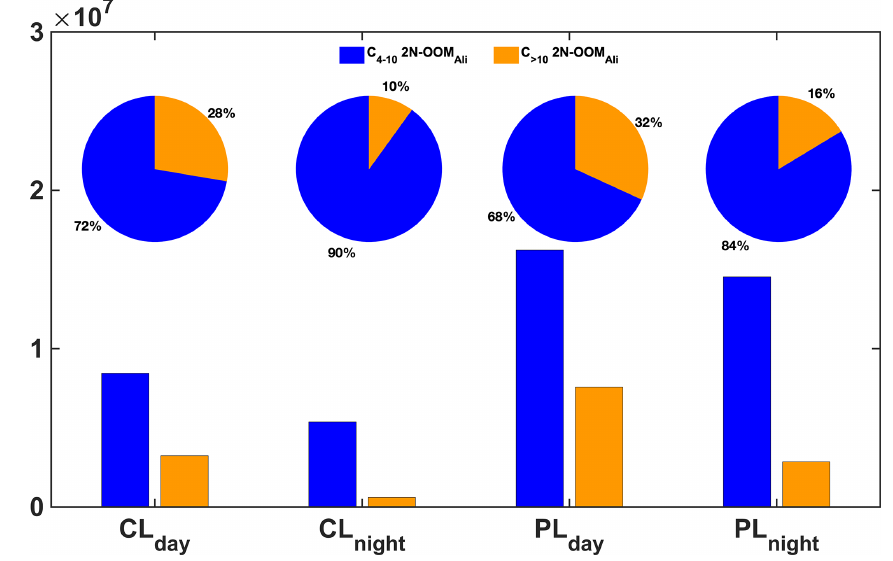
Figure 3. The fractions of 2N-OOM Ali with different carbon numbers in the four